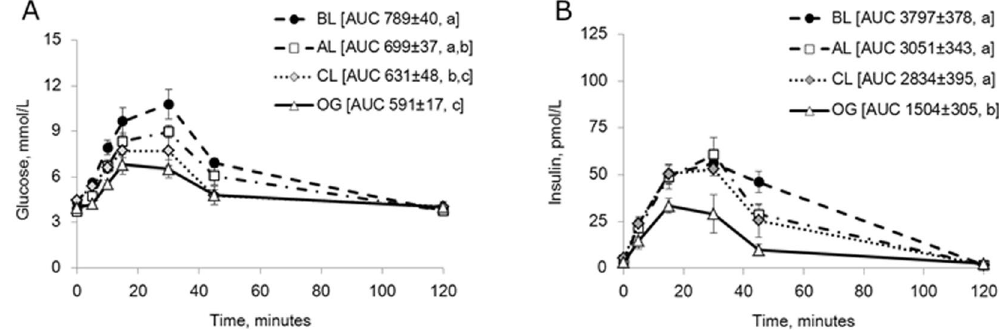
Figure 6. ( A , B ) Blood glucose ( A ) and plasma insulin ( B ) concentrations during GTT, infusing glucose either into the biliopancreatic limb (BL), the alimentary limb (AL), or the common intestinal limb (CL), in comparison to an oral glucose challenge (OG) in DJB pigs. Data shown as mean ± SEM (n = 5) with AUC values shown in brackets. Different letters indicate statistically significant differences (p < 0.05) between control and glucose infusion to the different limbs.